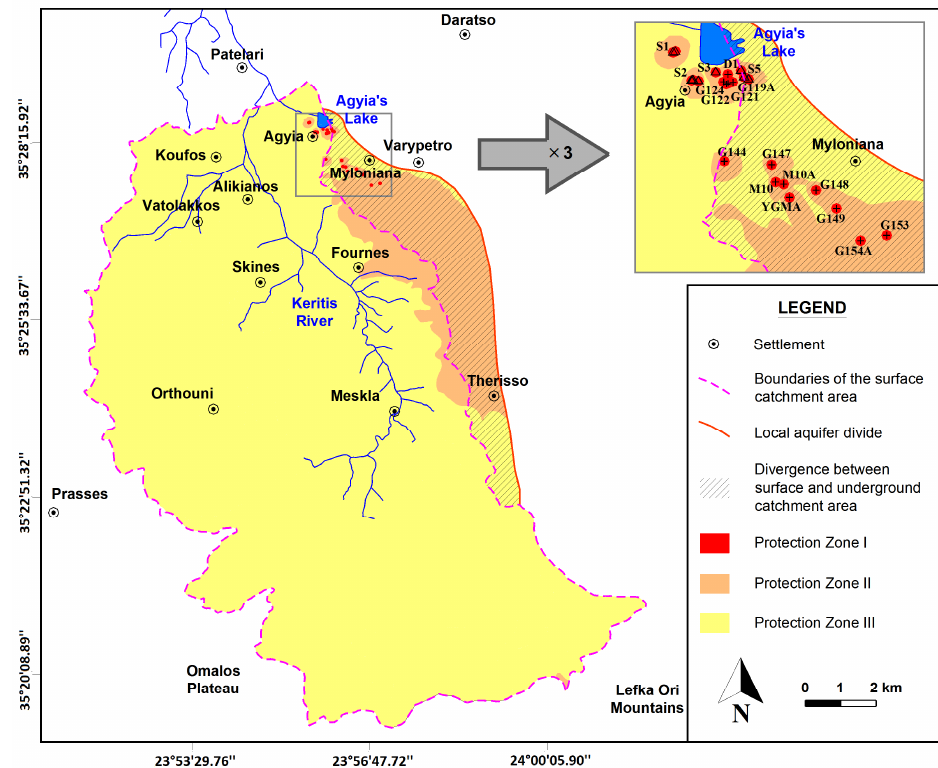
Figure 12. Protection zones in the discharge area of Agyia’s karstic system.